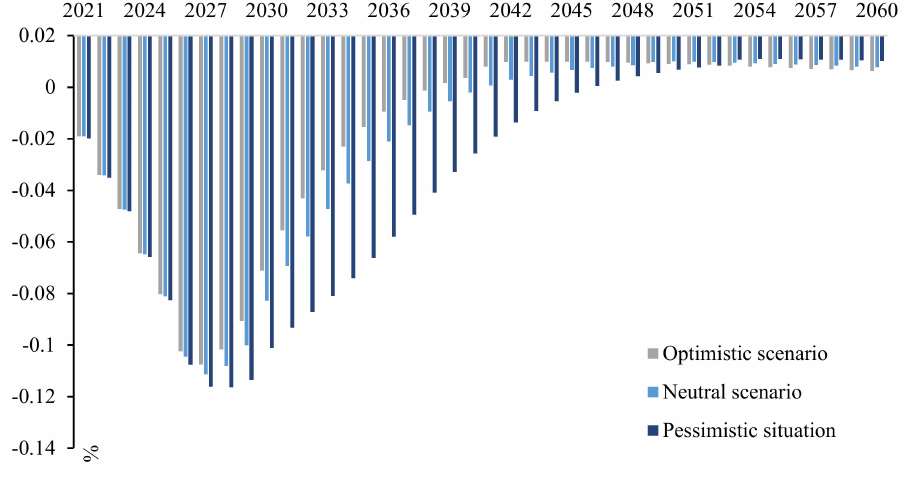
Figure 12. Changes in GDP of different technology curves.